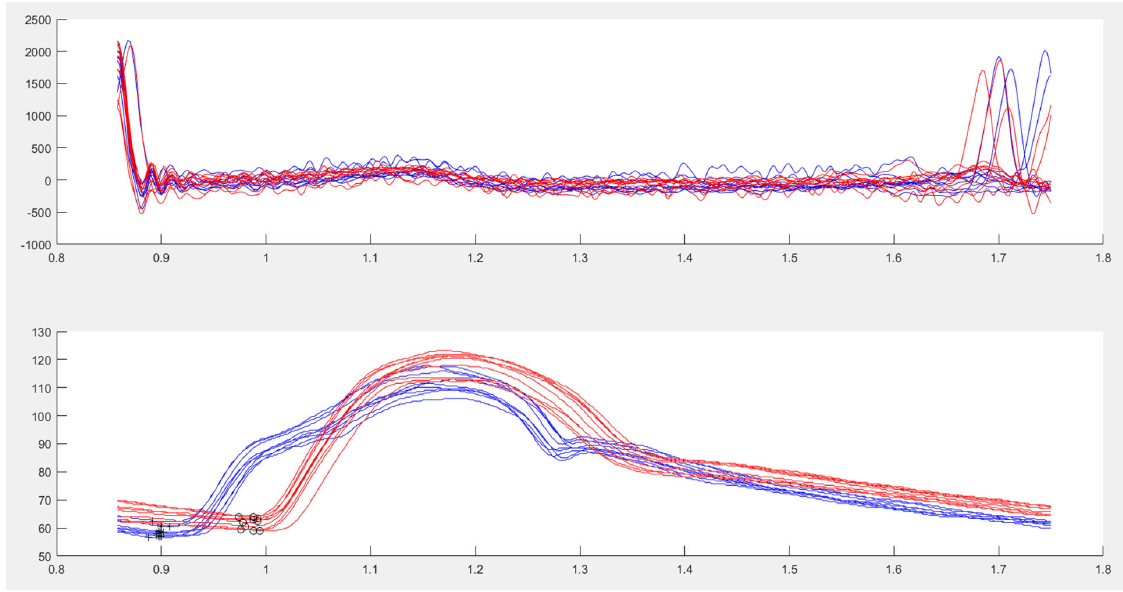
Figure 3. Measurement method to calculate aorto ‐ brachial pulse wave velocity. Upper panel: super ‐ position of R ‐ wave of the electrocardiogram for both measurements. Lower panel: superposition of invasive aortic (blue) and brachial (red) pulse pressure waves, gated to the R ‐ wave of the electro ‐ cardiogram and the foot of each BP rise (+ for aortic, o for brachial). An aorto ‐ brachial pulse wave velocity (abPWV) was calculated from the measured length of the pullback and the time delay between the ascending aorta and the brachial artery pulse wave foot estimated by the maximum upstroke of their second derivative, gating both measurements to the R ‐ wave of the ECG [32].